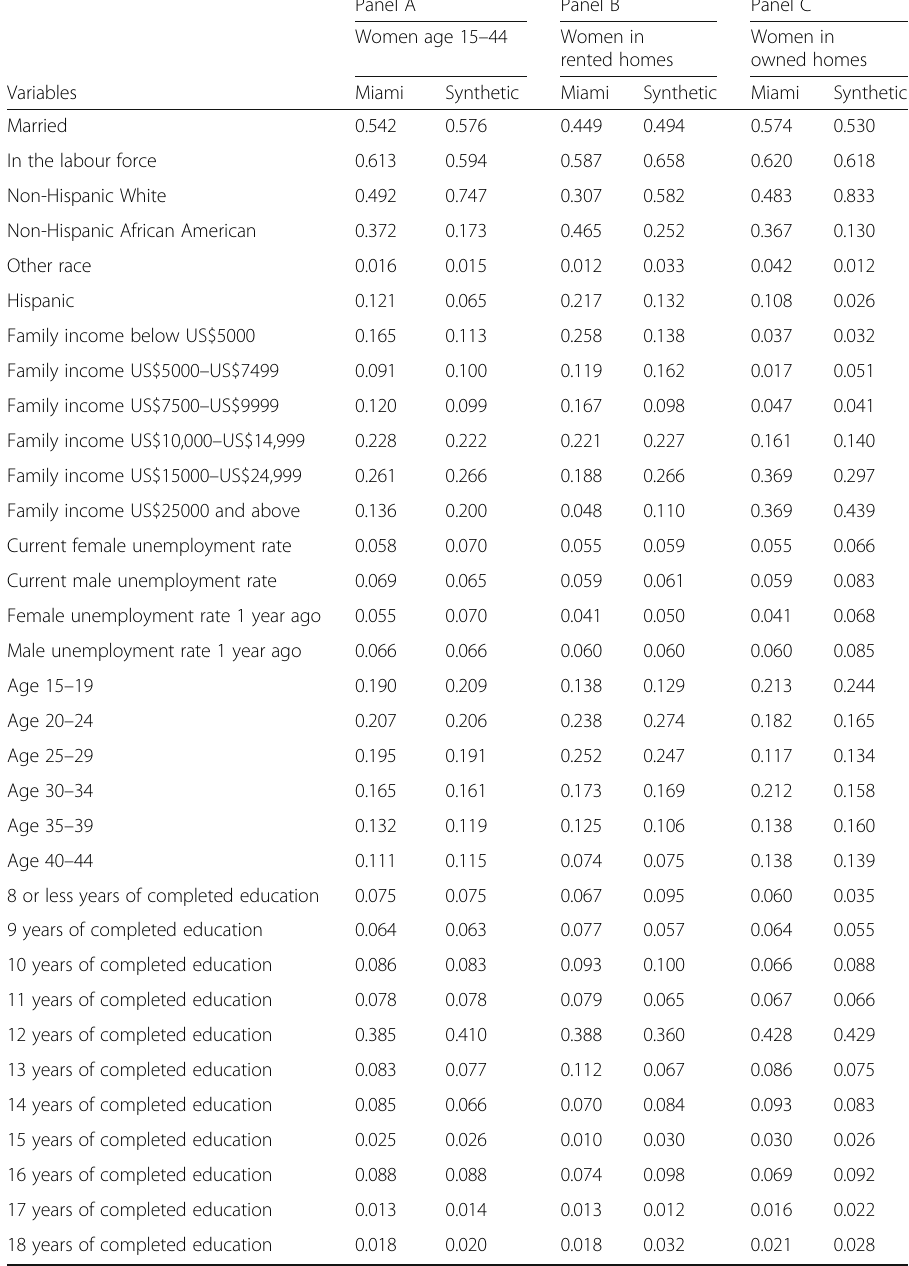
Table 3 Characteristics relevant to predicting fertility rates Panel A Panel B Panel C Women age 15 –